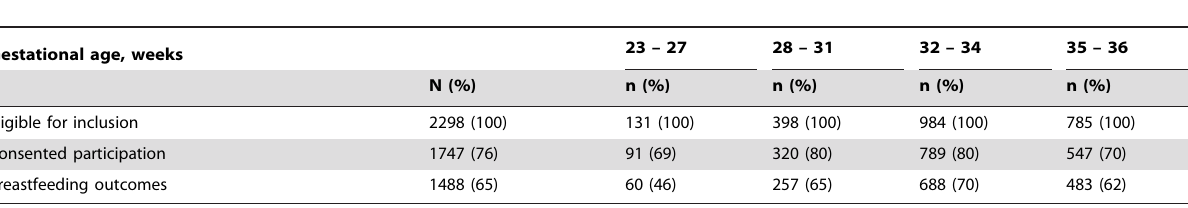
Table 1. Gestational age groups and drop